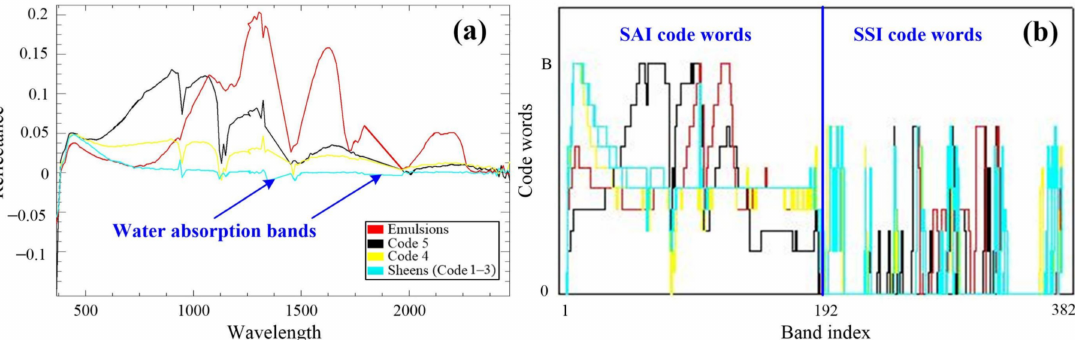
Figure 3. The spectra of oil slicks formed by the leaked crude oils in an AVIRIS image ( a ) and their encoding results (0 − B were the encoded code words) by the MSE method with SSI (( b ) scale = 12).